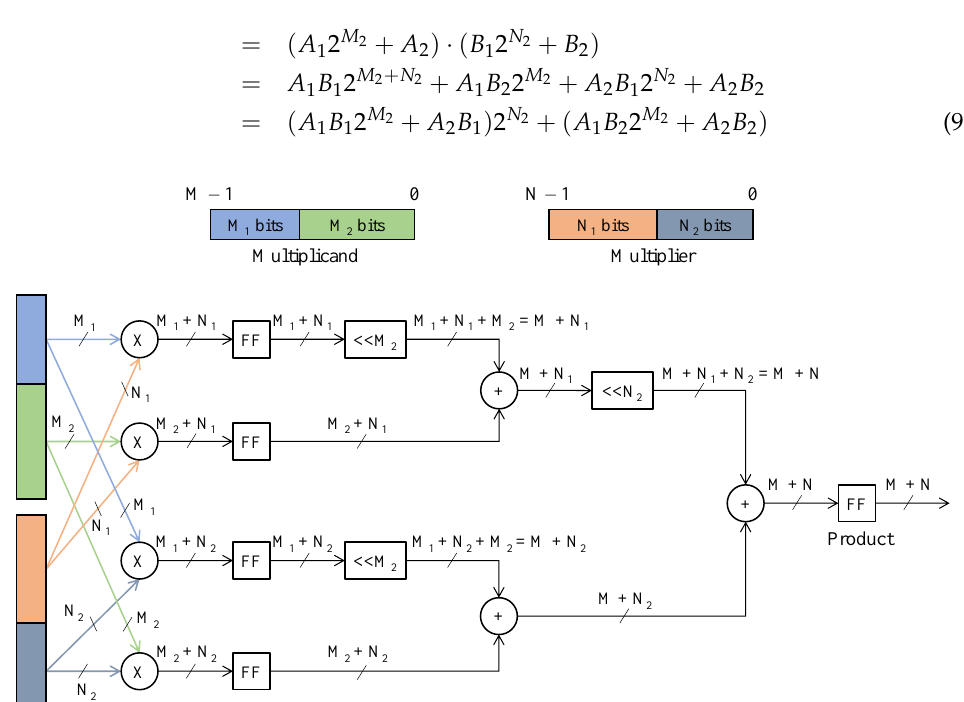
Figure 9. Block diagram of split multiplier for real-time